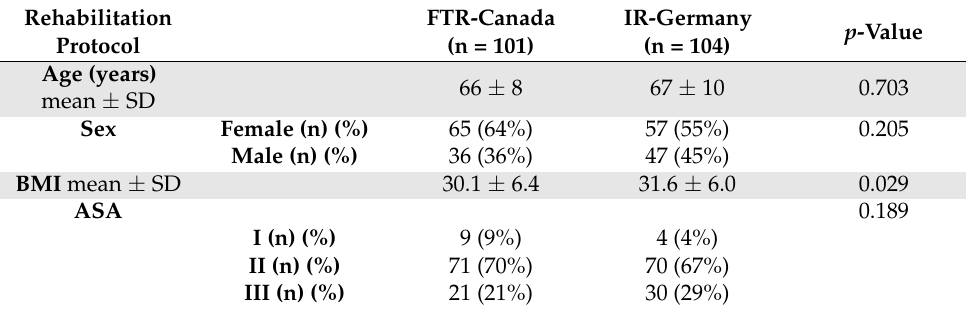
Table 1. Patient pre-operative